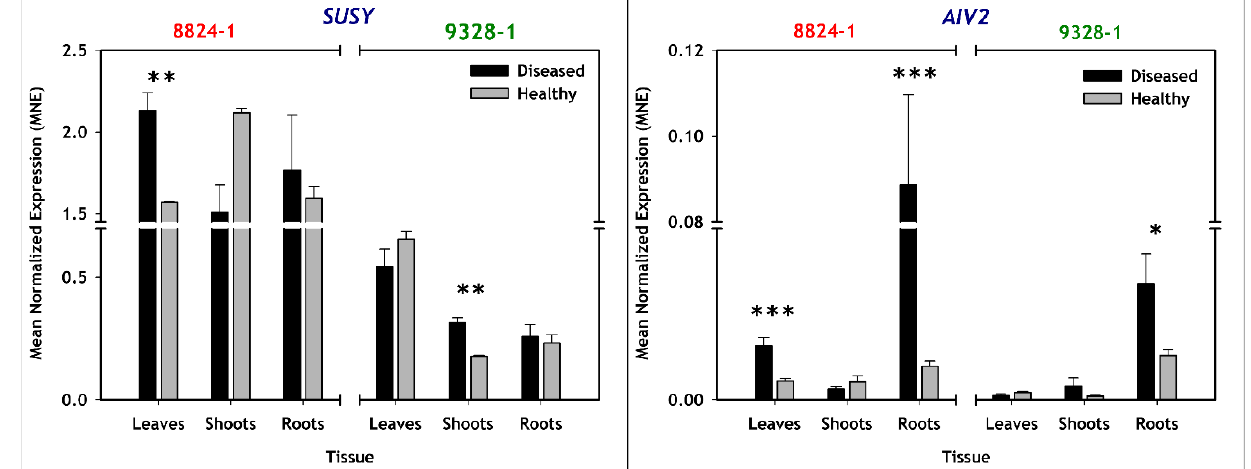
Figure 3. Bar plots representing relative expression of genes involved in carbohydrate metabolism ( SUSY and AIV2 ) in leaves, shoots and roots of non-infected (grey) and PD-infected (black) pear selections 8824-1 and 9328-1. The data are expressed as mean normalized expression (MNE) against GAPDH , which is proportional to the relative quantity of mRNA in a given tissue. The MNE of each sample was determined from 3 biological replications with 2 repeats per biological replication. Asterisks indicate means that were significantly different (Tukey ’ s post hoc test, p < 0.05) with standard errors shown, and *, **, and *** indicating statistical significances of p < 0.05, p < 0.01, and p < 0.001, respectively.